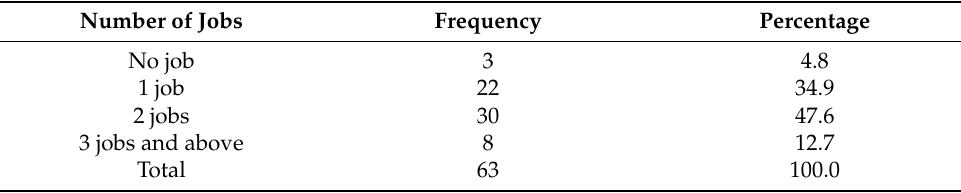
Table 4. Job diversification by domestic unit head.